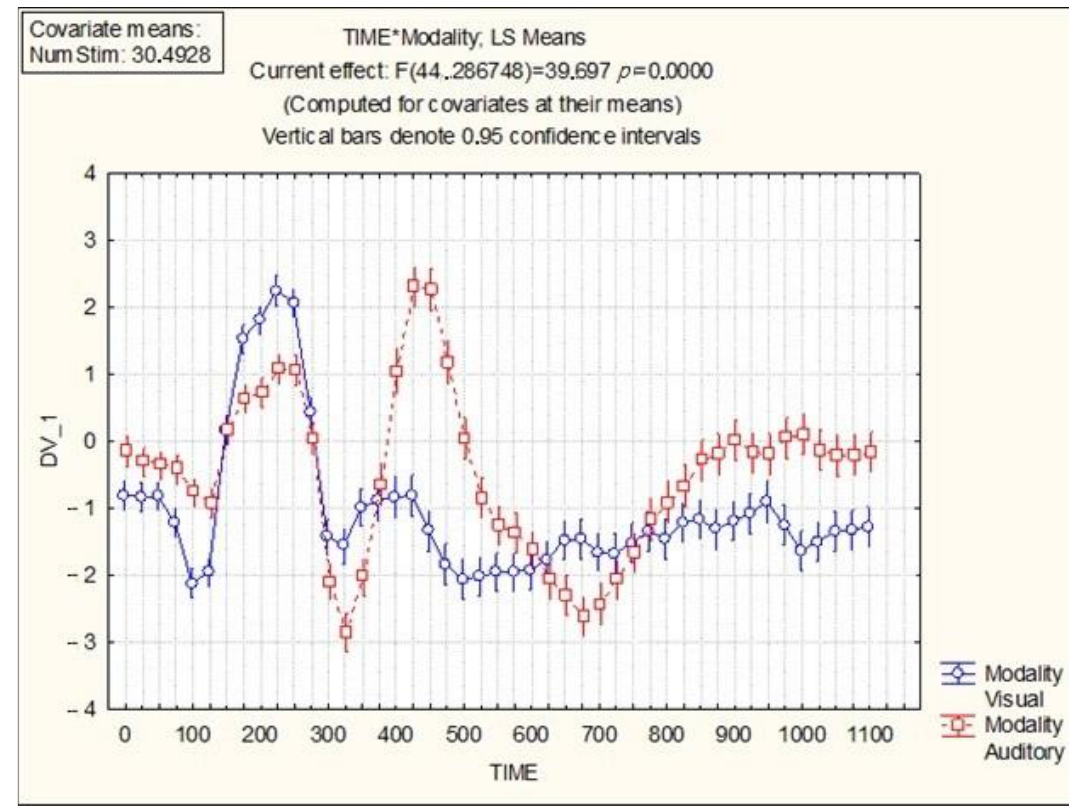
Figure 1. Modality (visual, auditory) impact on the time parameters in integrative brain activity. '*' is a multiplication sign.